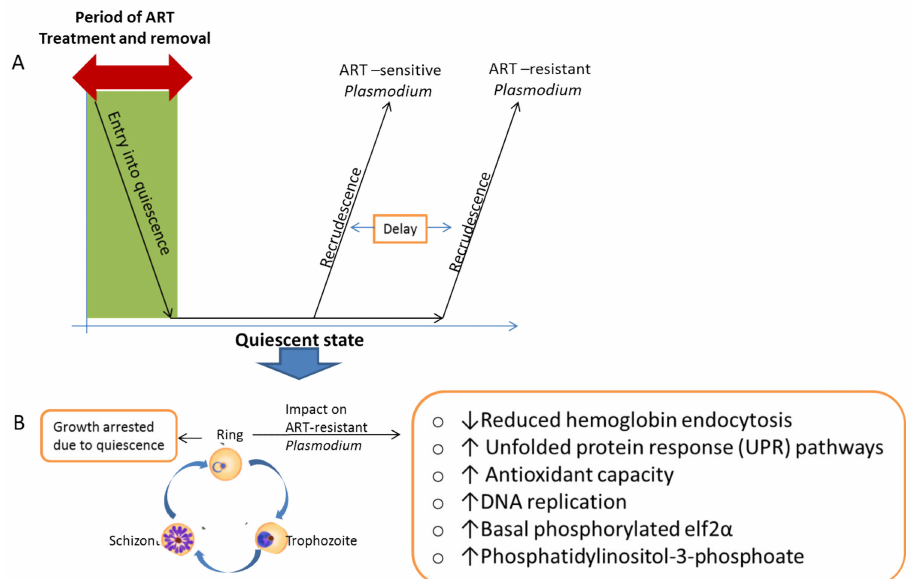
Figure 2. Resistance development selection due to artemisinin drug pressure. The drug pressures lead to the selection of resistant parasite phenotypes conferred by gene mutations that can be passed on to the next generations. ( A ) The impact of ART exposure on ART-sensitive and ART-resistant Plasmodium , where a subpopulation goes into quiescence and recrudesces when the ART is removed, where there is a delay in the recrudescence of the resistant strains. ( B ) Characteristics of the quiescence-based artemisinin resistance. ART =